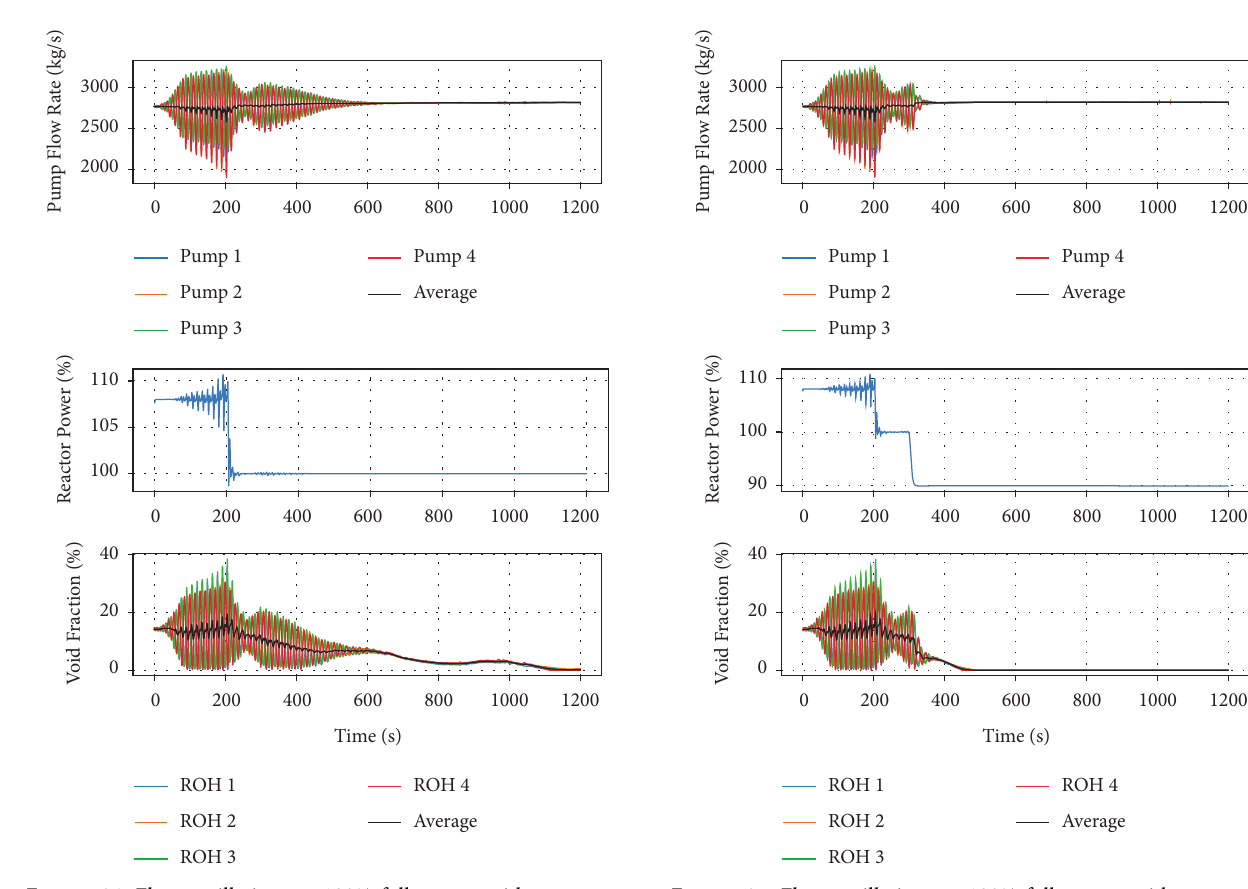
Figure 24: Flow oscillations at 108% full power, with power re- duced to 100% after 200 seconds. The even pair of pumps and headers oscillate out-of-phase with the odd pair.